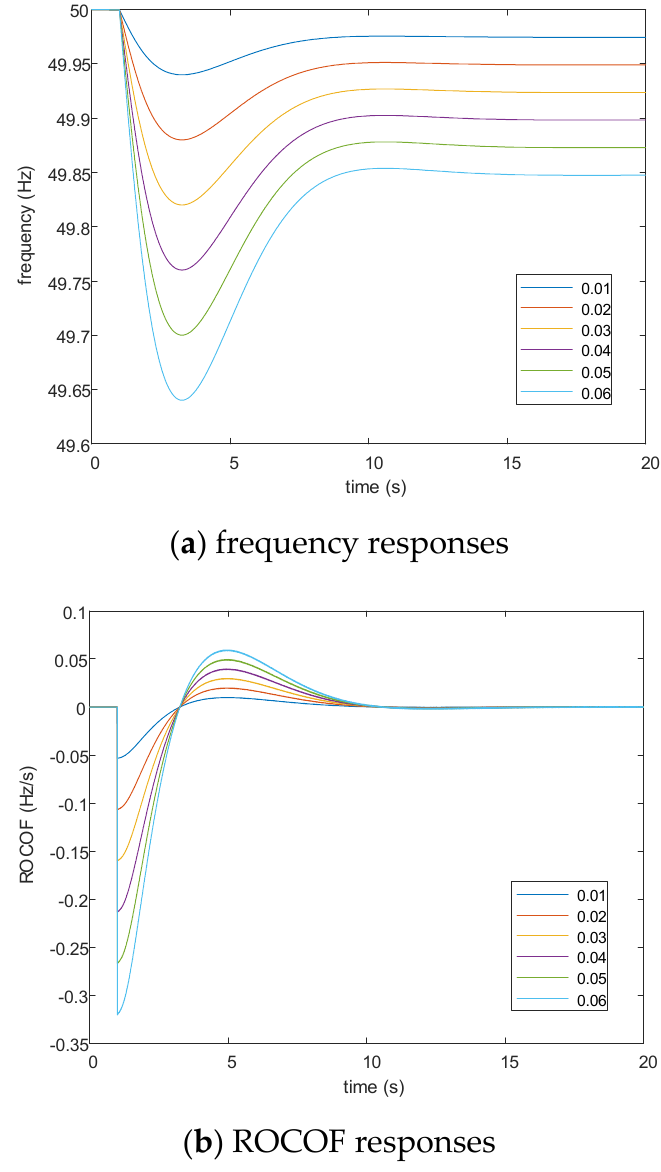
Figure 16. Dynamic responses without adaptive parameters.